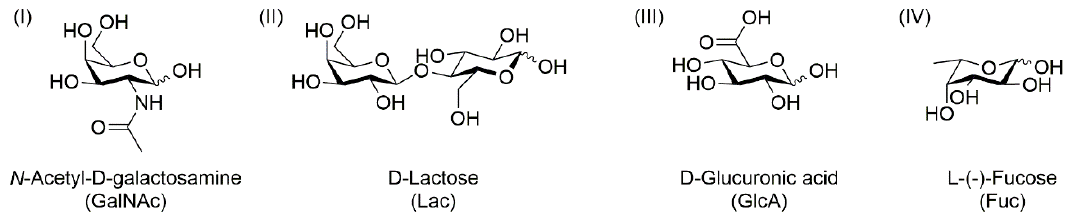
Figure 1. Mono- and disaccharides chosen for the optimization of amination reactions.